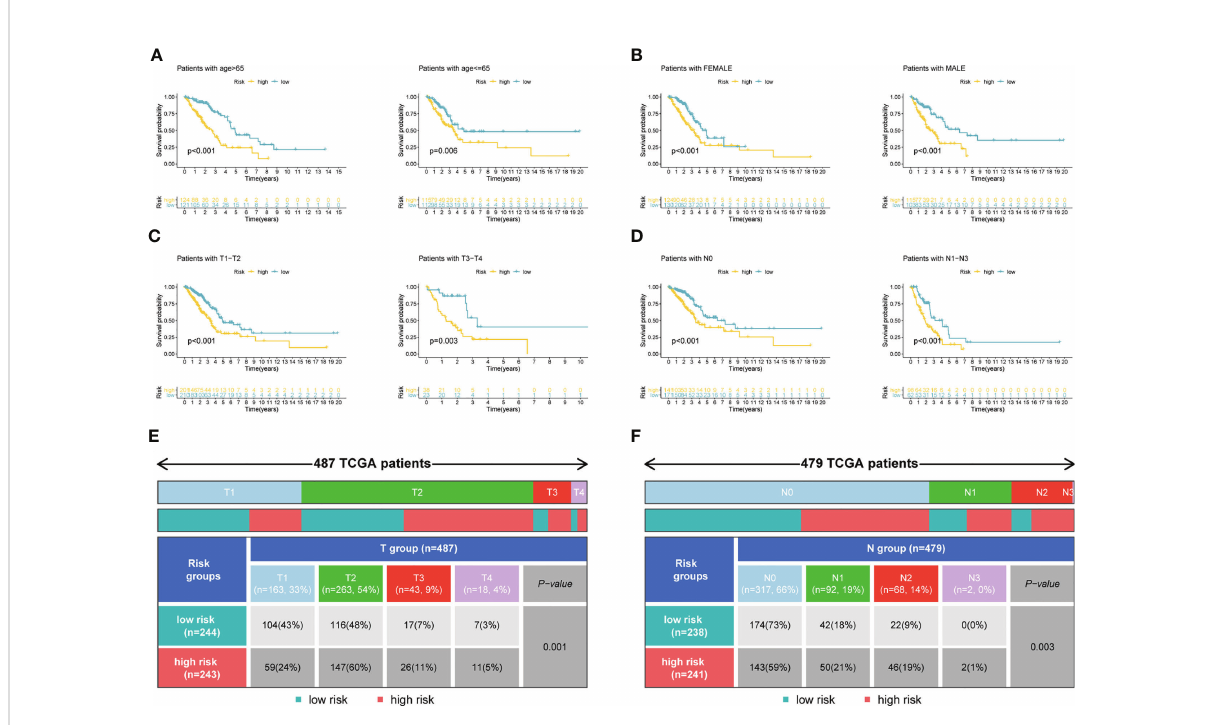
FIGURE 5 Subgroup survival analysis. (A) Age subgroup. (B) Gender subgroup. (C) T stage subgroup. (D) N stage subgroup. (E, F) Table presenting the distribution of T and N stage subgroups between two risk groups.